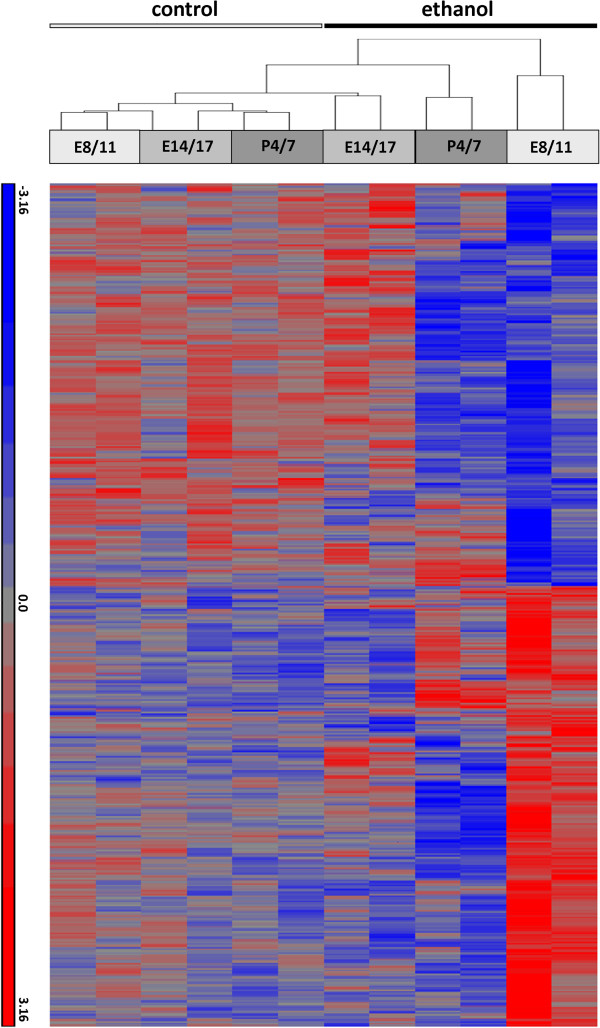
Heat map representing hierarchical clustering of arrays based on the normalized intensity of the probe sets. Control and ethanol-treated samples are indicated (n=2), with each replicate consisting of RNA pooled from three male mice obtained from six litters. Treatment times are also indicated. Heat map was generated by Partek® Genomics Suite software based on ANOVA-calculated significance levels at a fold-change cutoff of 1.2 and a FDR-corrected P value <0.05.